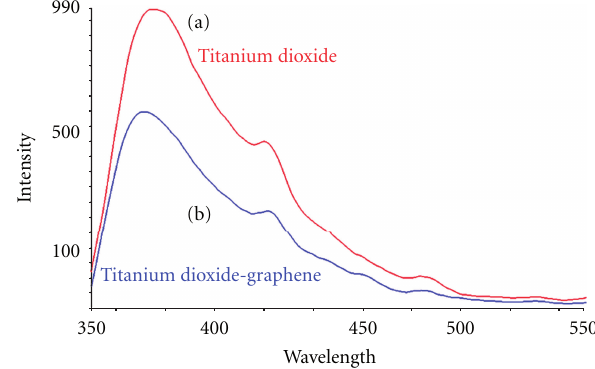
-graphene composite. 2